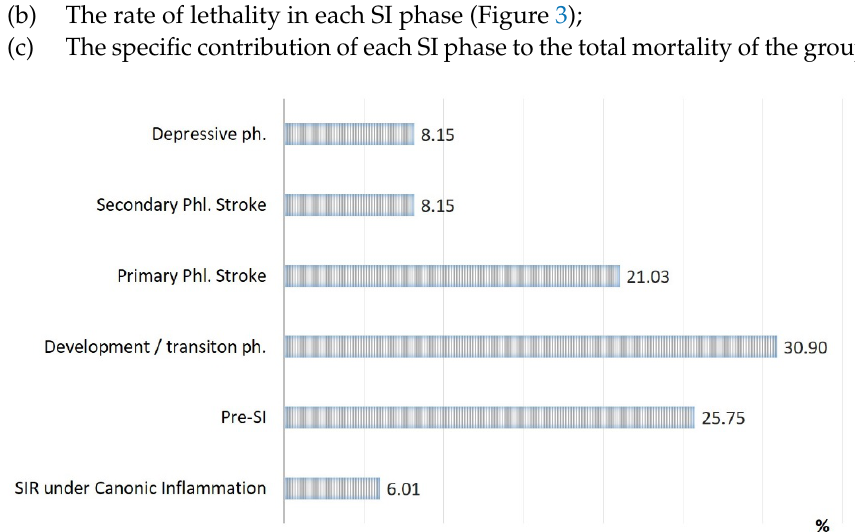
Figure 2. Distribution of patients in the study groups by type of inflammation and phases of SI (n = 233).